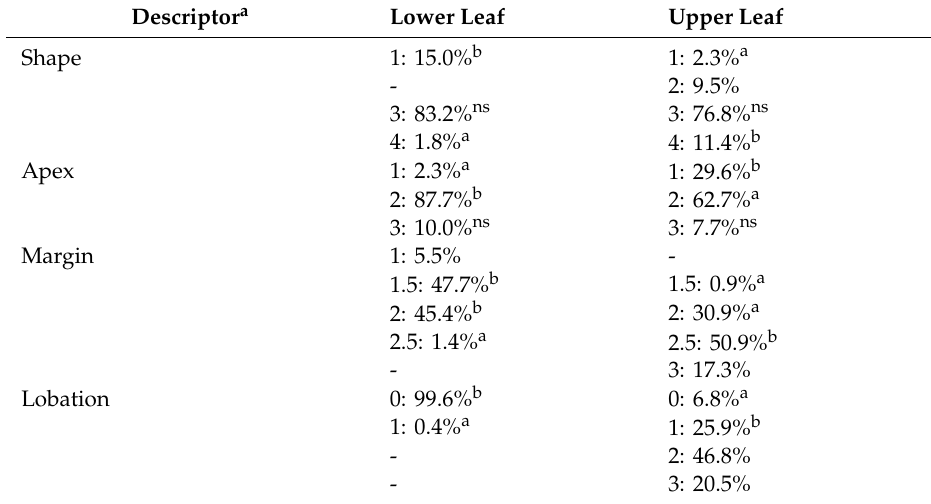
Table 4. Percentage of leaf-related categorical traits analyzed in the populations of wall rocket, for the lower and upper leaves ( n =